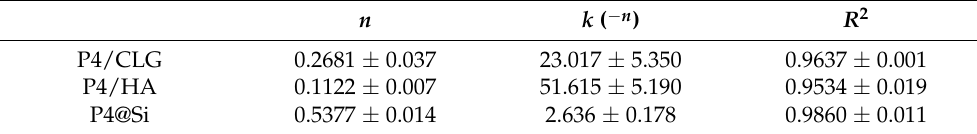
Table 3. The Korsmeyer–Peppas model fits of P4 release from the carrier.